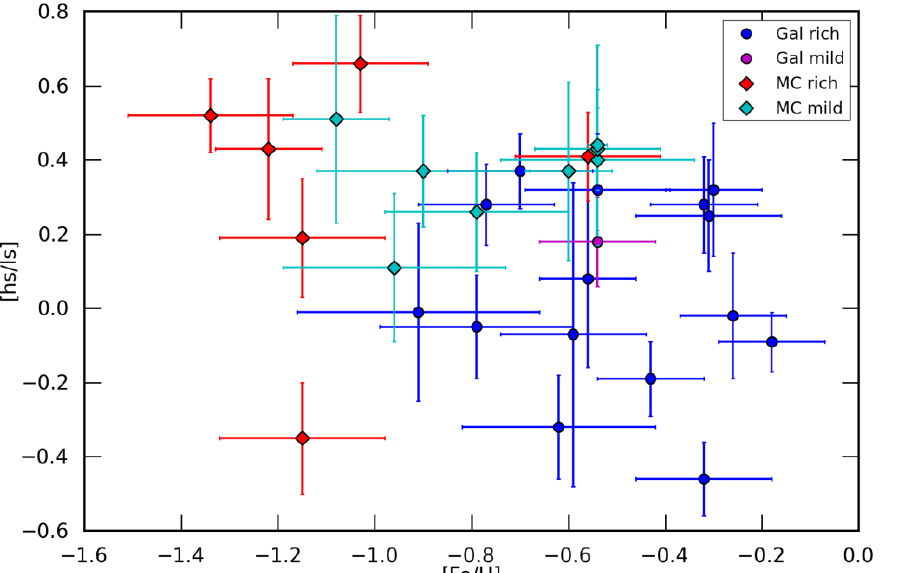
Figure 4. [Fe/H] versus [hs/ls]. Within the metallicity range covered by the s -process-rich post-AGB stars, there is no correlation between neutron exposure, as depicted in the [hs/ls] ratio, and intrinsic metallicity—for the Galaxy and for the LMC/SMC. Figure from